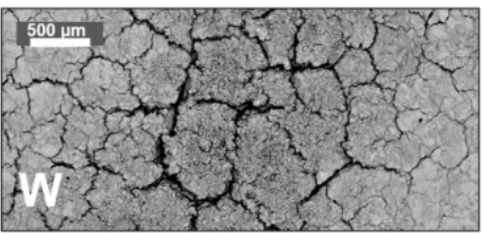
Figure 6. Surface damage with cracks induced by electron beam pulses. Reprinted from Ref.